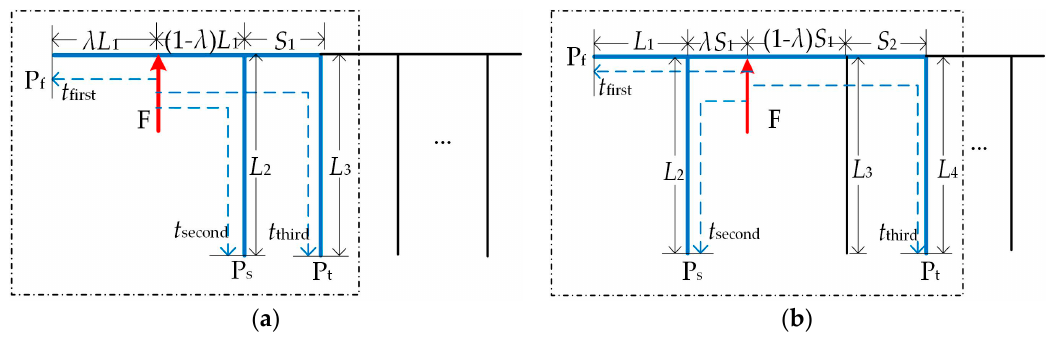
Figure 6. Situation of the first three arrival times detected from both direction. ( a ) Fault in a branch. ( b ) Fault in main line between two tap nodes.